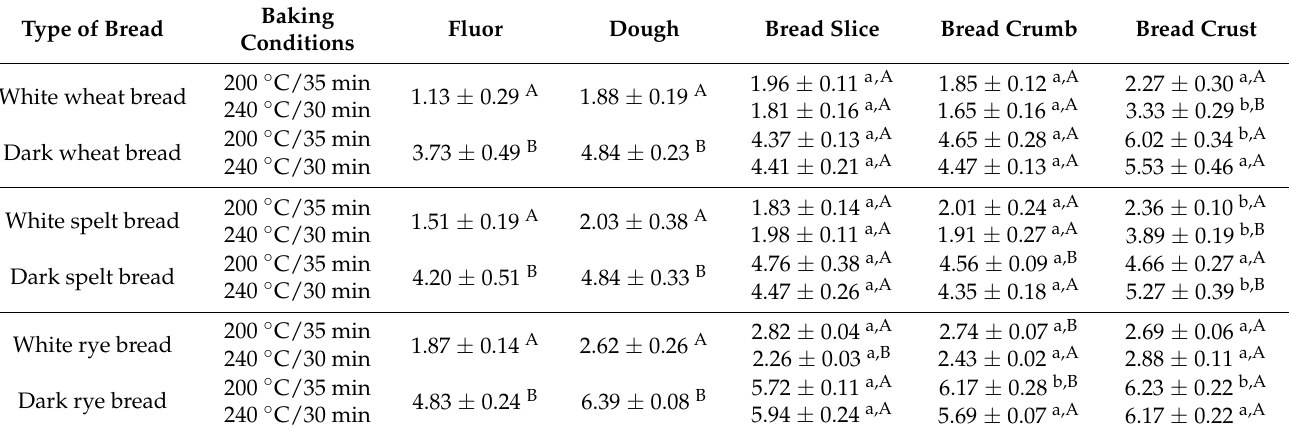
Table 3. The total reducing capacity (TRC) of flours, doughs, slices, crumbs, and crusts originated from white and dark wheat, spelt, and rye breads ( µ mol Trolox/g